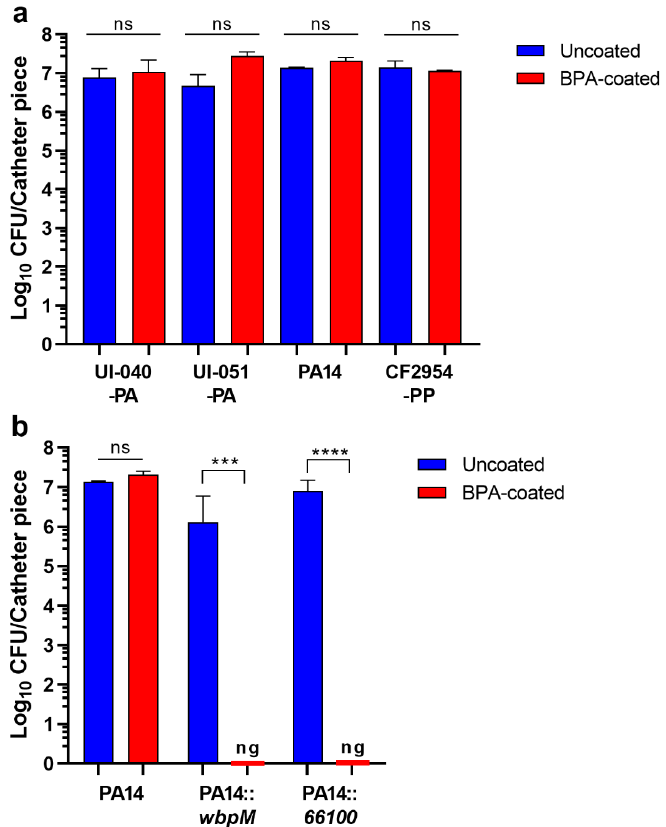
Figure 6. Pseudomonas species are tolerant to BPA-coated catheters. (a) Uncoated and BPA-coated catheters were placed in AUM inoculated with two additional P. aeruginosa UTI isolates (UI-040-PA, UI-051-PA), the virulent P. aeruginosa laboratory strain (PA14), and a respiratory isolate of P. putida (CF2954-PP). (b) Isogenic LPS mutants of PA14 are sensitive to the BPA-coated catheters. Uncoated and BPA-coated catheters were placed in AUM inoculated with PA14 (parent strain) and its isogenic mutants PA14:: wbpM and PA14:: 66100 . Bars represent the average of three independent experiments ± SEM; ns, no significance; ***, p < 0.001; ****, p < 0.0001.